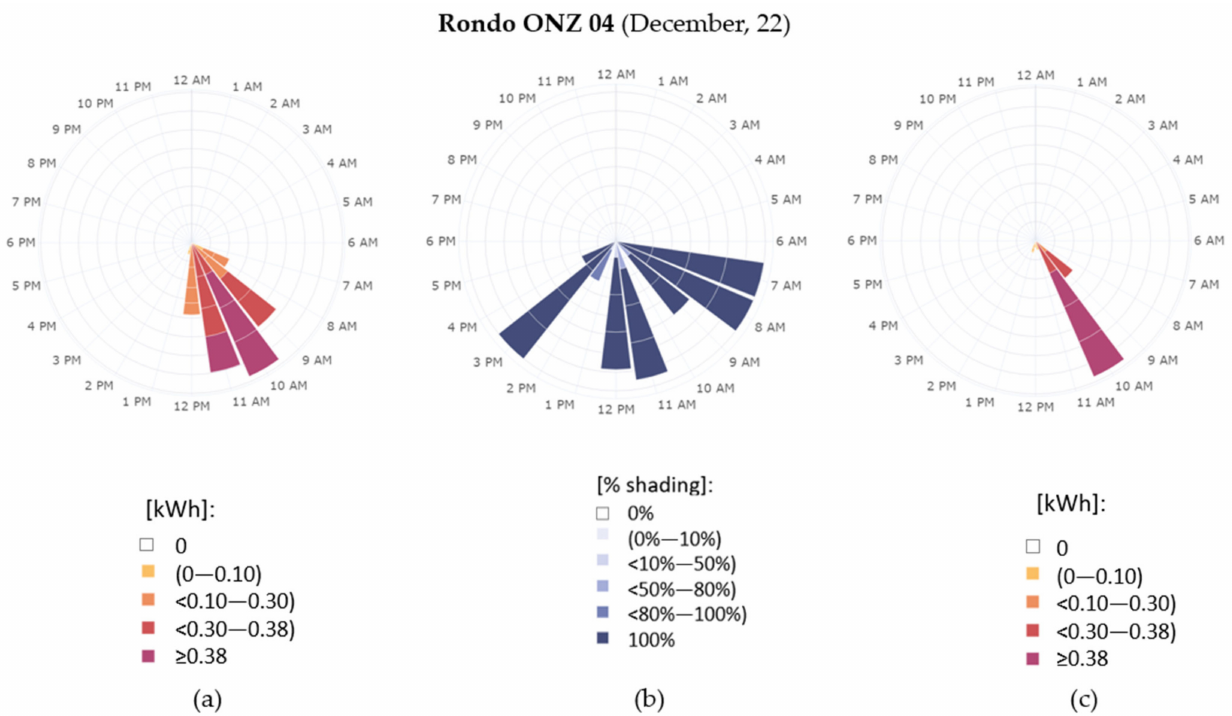
Figure 26. Results obtained for the shelter roof in the neighbourhood of Rondo ONZ 04 tram stop for 22 December 2020: ( a ) solar potential in kWh per stop shelter roof area; ( b ) percentage loss due to shelter shading; ( c ) actual solar potential including shading (kWh) per stop shelter roof area. The maximum value is about 1.8 kWh (6.48